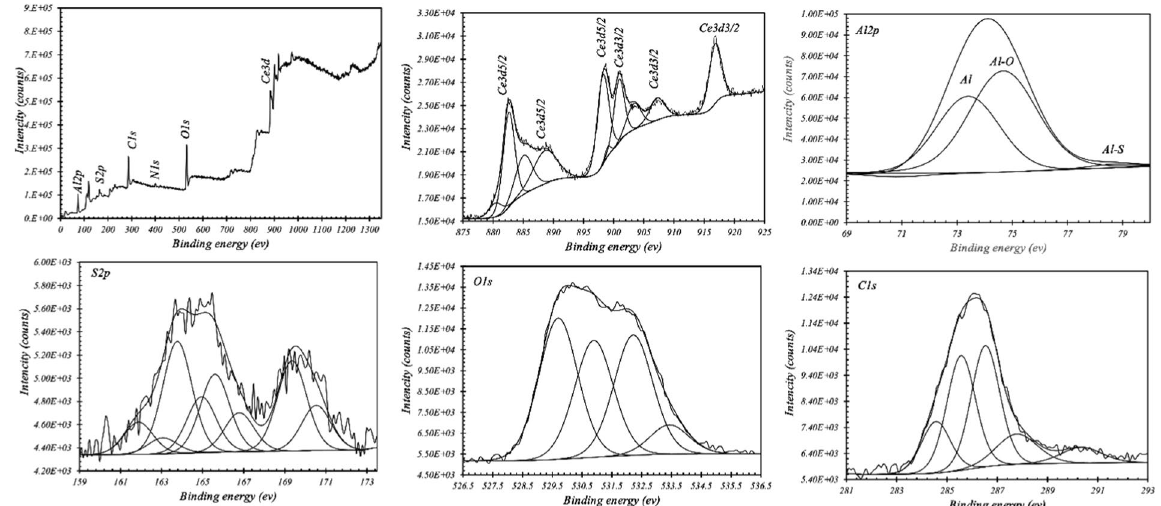
Figure 11. The XPS survey and high-resolution spectra of Ce 3 d, Al 2 p, S 2 p, C 1 s, and O 1 s.